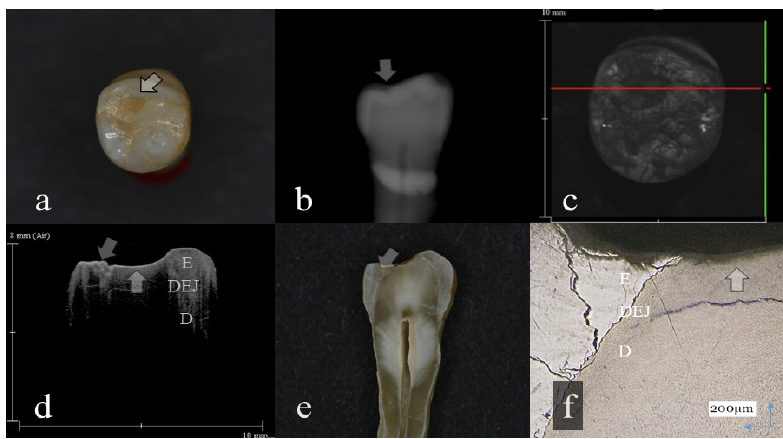
Figure 6. Tooth wear with distinct dentin exposure (score 4); ( a ): Occlusal view. The buccal surface was collapsed to show the scabrous appearance (arrow); ( b ): Digital intraoral radiography. Although the occlusal surface appeared flattened, evaluation of tooth wear level was difficult because of the overlapped image (arrow): ( c ): OCT en face intensity projection; ( d ): SS-OCT image. The tooth wear for both enamel and dentin was clearly imaged. Brightness of exposed dentin subsurface was increased, suggesting dentin demineralization (arrow). The distinct white zone penetrating along DEJ was an enamel crack (arrow); ( e ): Histological view. Tooth wear for both enamel and dentin was evident. The subsurface enamel near DEJ was cracked (arrow); ( f ): CLSM image of histological view. Many crack lines in the enamel were penetrated with changing the direction to reach the DEJ. Subsurface dentin appeared demineralized (arrow). The corresponding dynamic slicing 3D video is in Supplementary Materials: Video S6. The upper right is a cross sectional image. Lower right is an en face image.